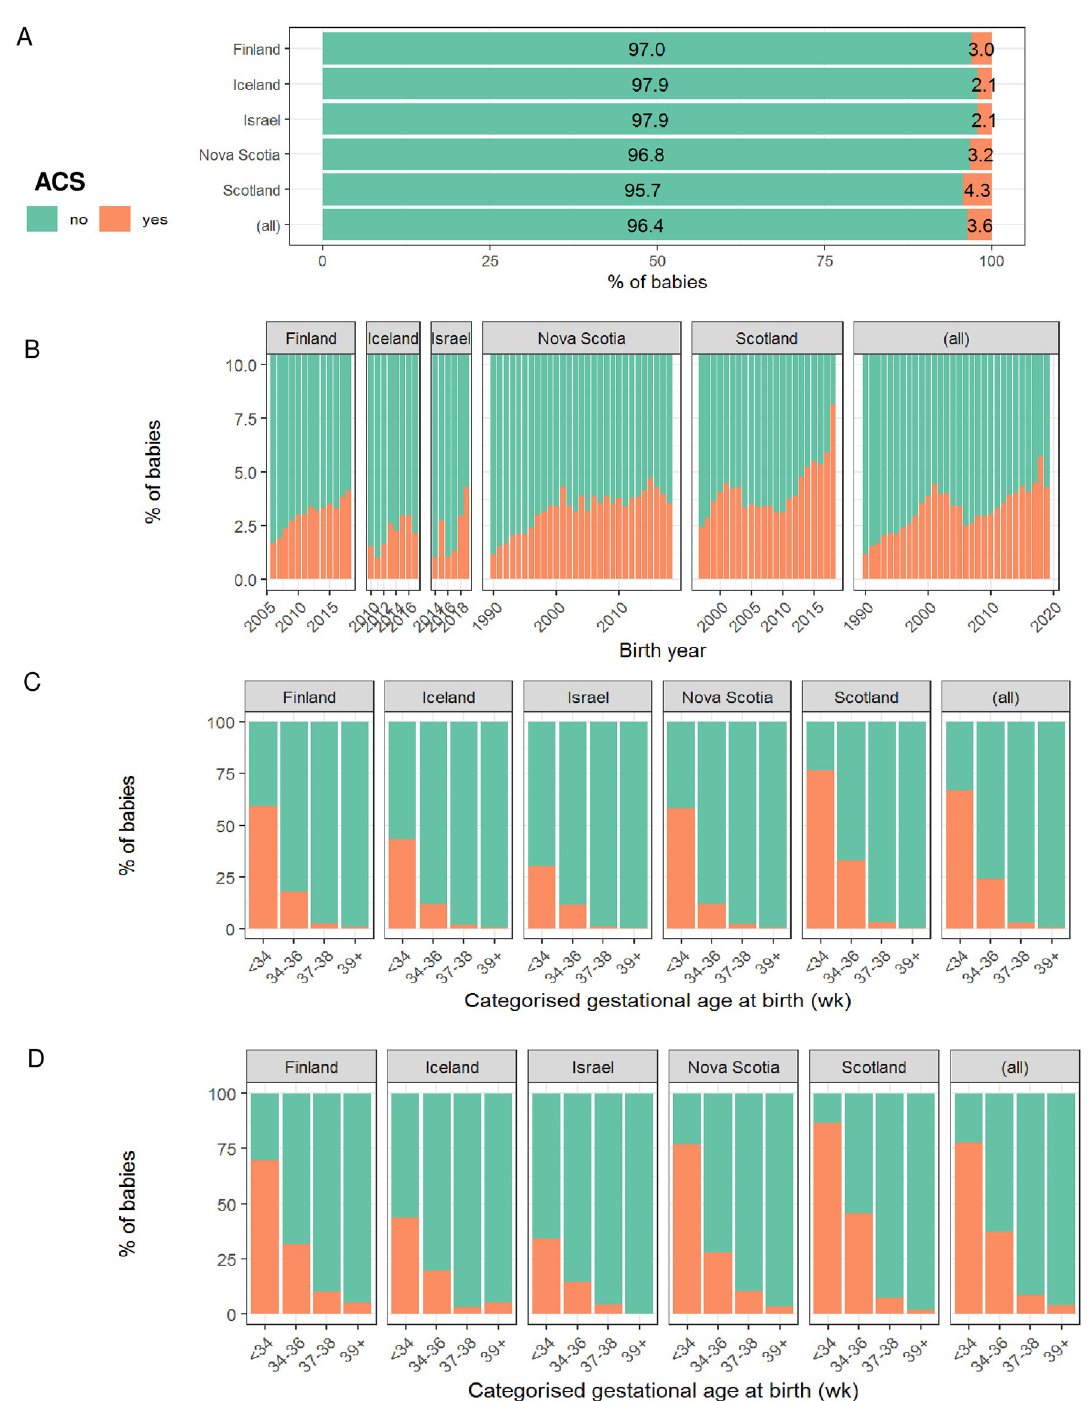
Fig 4. Rates of ACS exposure in the ACS cohort. (A) Overall rates of ACS exposure in the Co-OPT ACS cohort. (B) Rates of ACS exposure in the Co-OPT ACS cohort over time. (C) Rates of ACS exposure in singleton births in the Co-OPT ACS cohort, based on gestational age at birth. (D) Rates of ACS exposure in multiple births in the Co-OPT ACS cohort based on gestational age at birth. Fig 4A-4D include live births and stillbirths. Singleton and multiple births are presented in Fig 4A-4C includes singleton births only and Fig 4D includes multiple births only. Cases with missing ACS data were excluded. (wk) = completed weeks of gestation. (all) = All babies in the Co-OPT ACS cohort. ACS = exposed to antenatal corticosteroids.